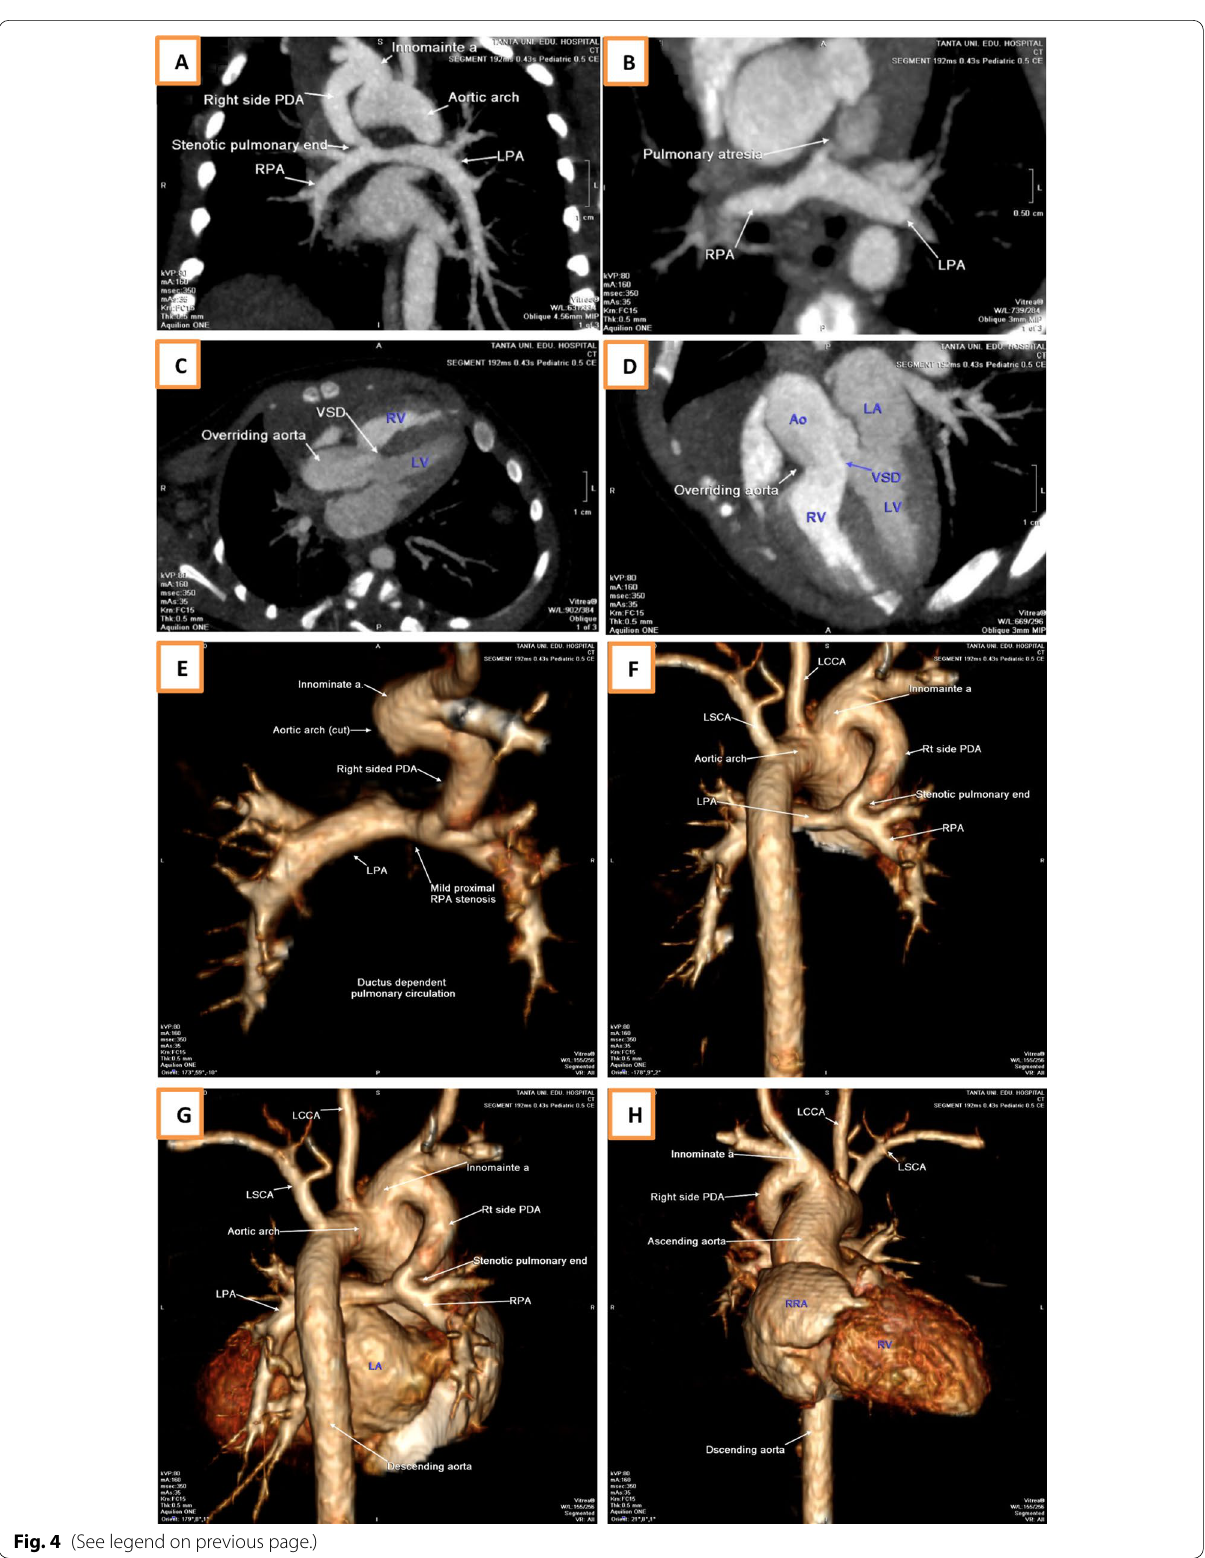
Fig. 4 (See legend on previous